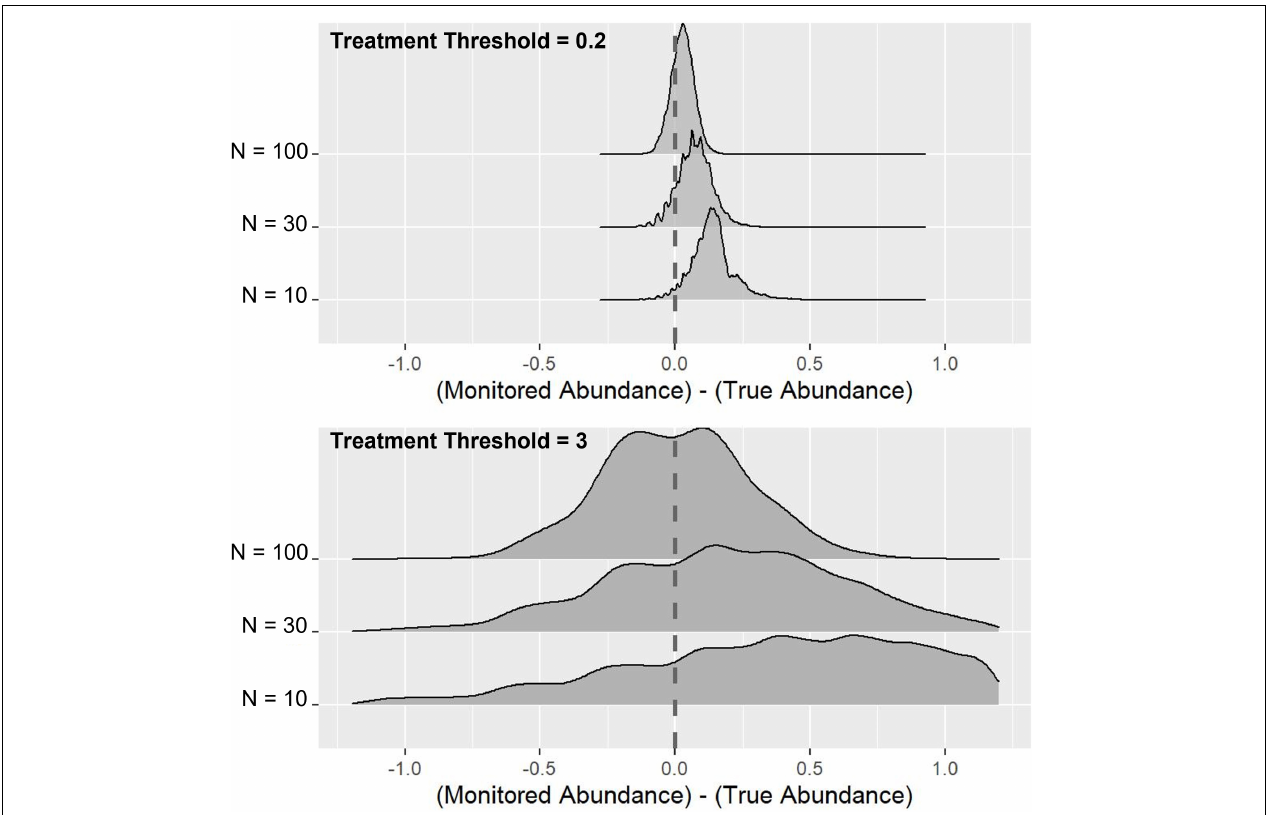
FIGURE 3 | Effects of sample size and treatment threshold on the difference between true abundance and monitored abundance. N represents the sample size, and the vertical dashed lines indicate the point where monitored abundance and true abundance were